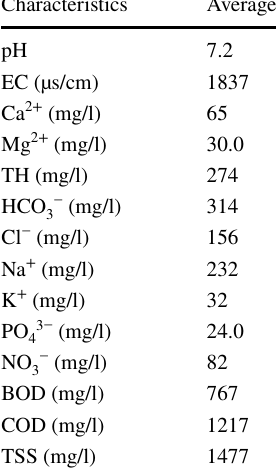
Characteristics